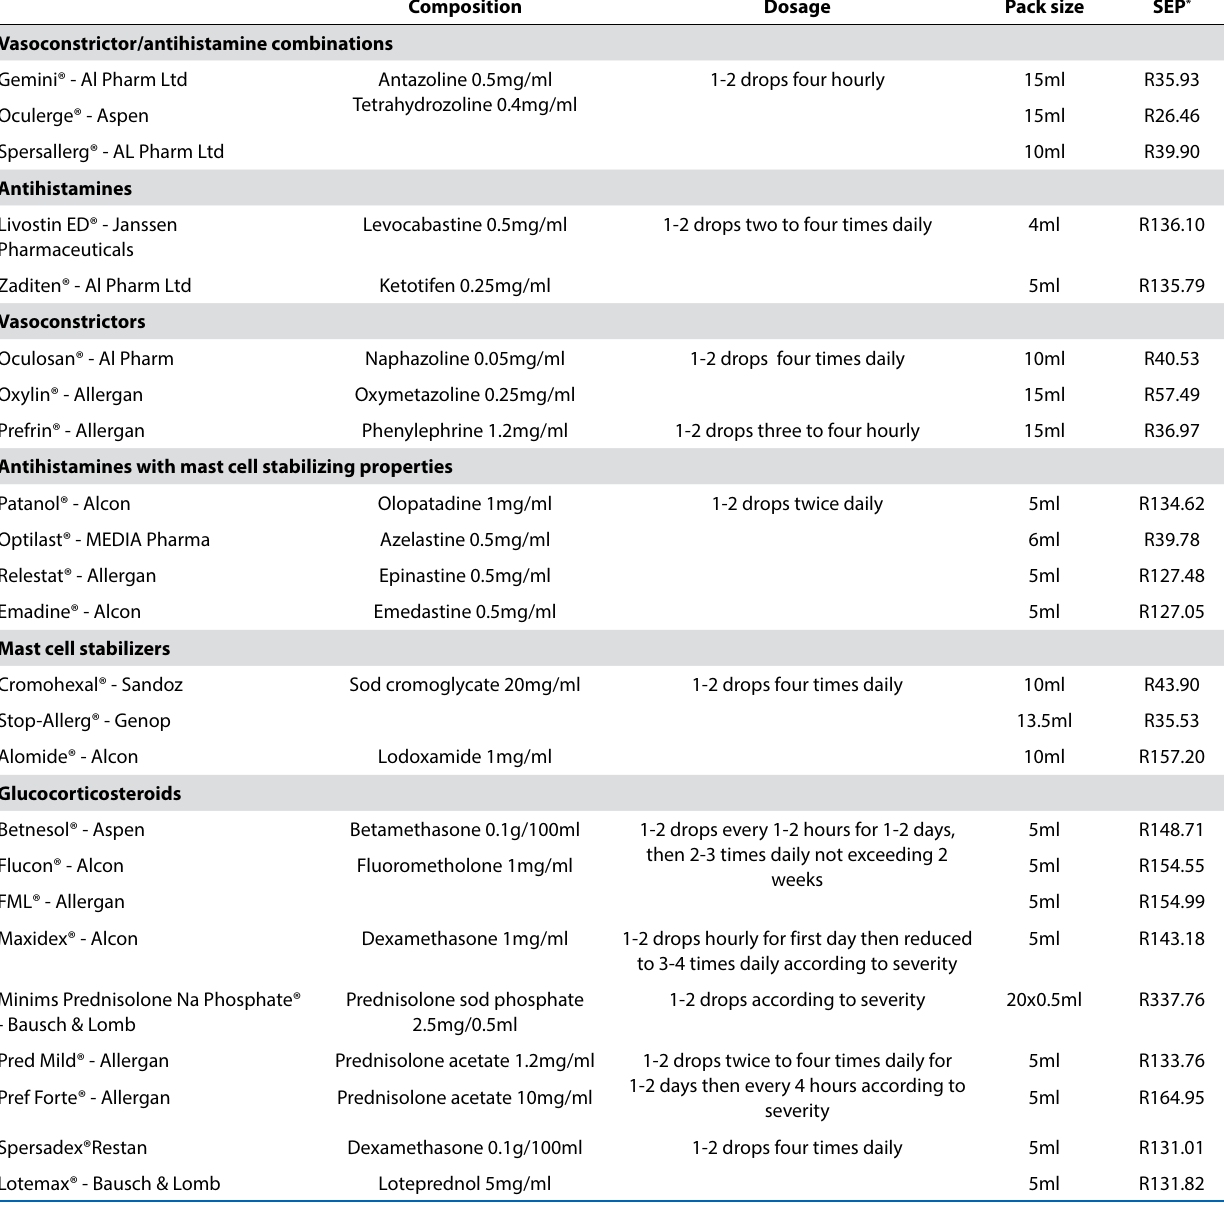
Table 1. Currently available topical preparations in South Africa for the treatment of allergic and non-infective conjunctivitis